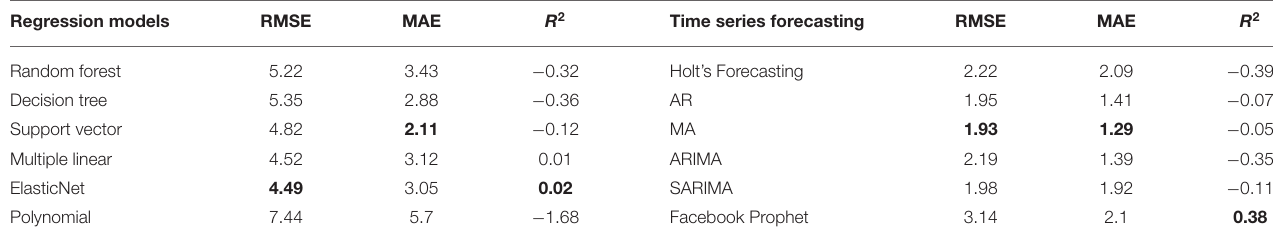
TABLE 4 | Performance metrics comparison table for Amravati.